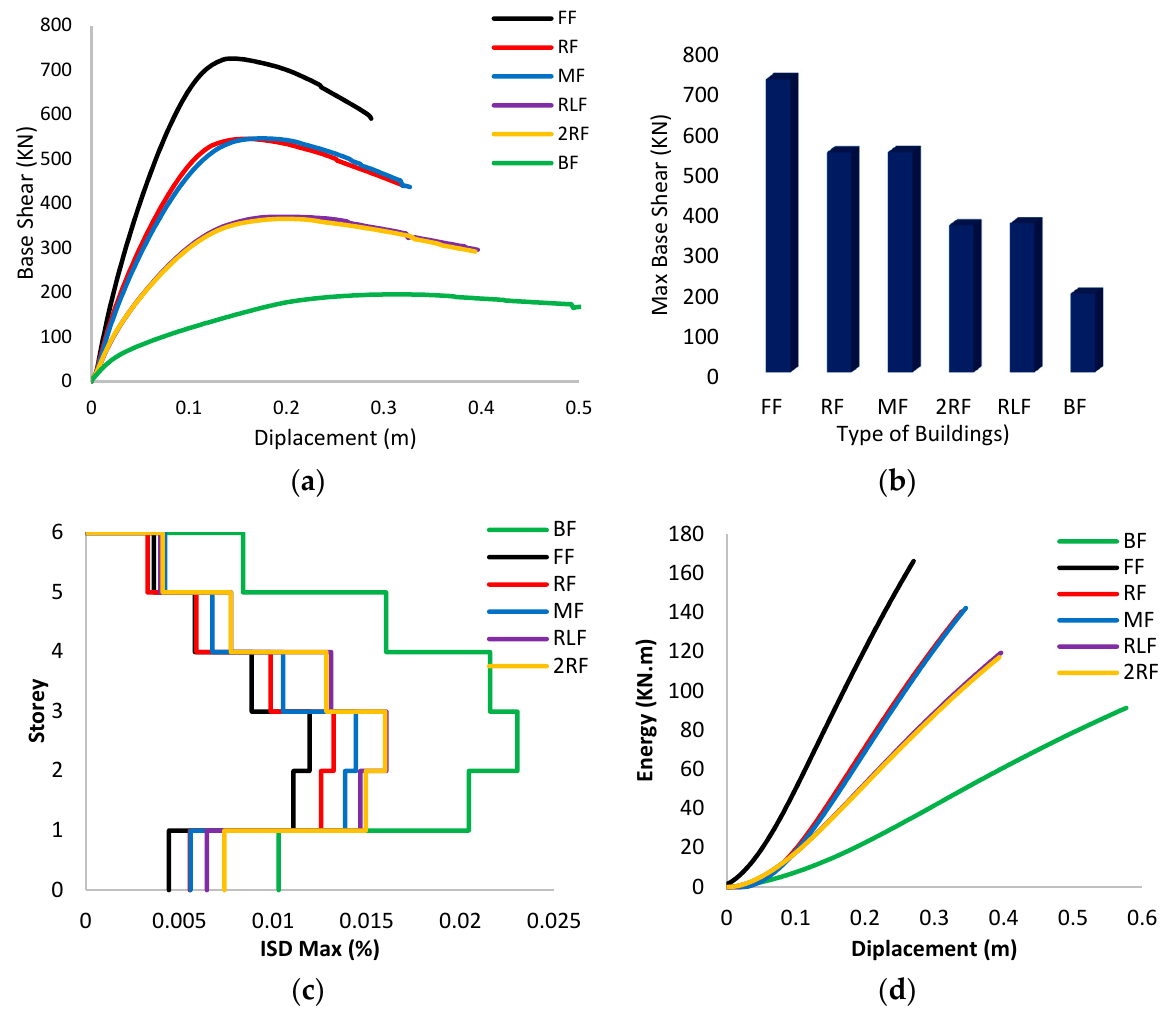
Figure 9. Case N°:2: ( a ) the capacity curve, ( b ) the maxillary base shear values, ( c ) the maximum ISD, ( d ) the energy absorbed curve of the building.